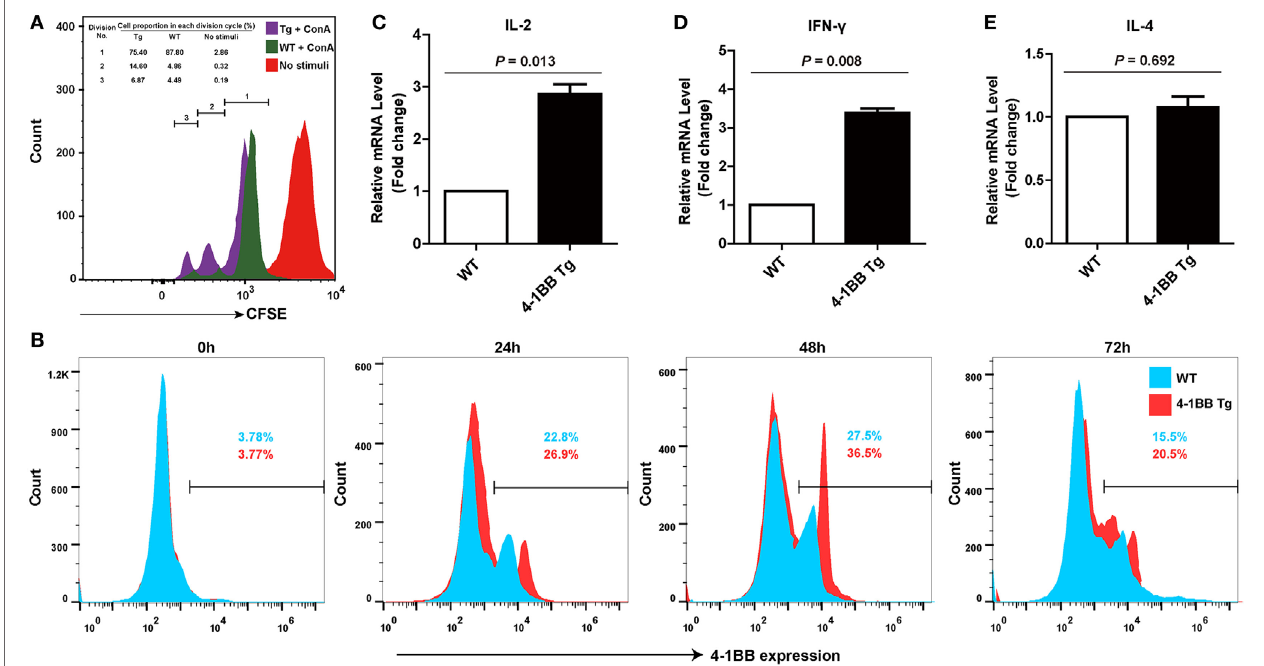
FigUre 4 | 4-1BB overexpression promotes the proliferation of peripheral blood lymphocytes and the levels of Th1 cytokines mRNA expression. (a) Equal numbers of peripheral blood lymphocytes were labeled with carboxyfluorescein diacetate succinimidyl ester and stimulated with concanavalin A. Representative results of an in vitro proliferation assay showed that 4-1BB transgenic pigs had a greater proliferation capacity compared with pigs of wild-type control. The percentages of cells in each division cycle compared with non-stimulated control (complete RPMI media) were indicated. (B) Kinetics of 4-1BB expression on in vitro activated T cells. Peripheral blood lymphocytes were stained for 4-1BB expression after stimulation with ConA at indicated times. (c–e) : IL-2 (c) , IFN- γ (D) , but not IL-4 (e) mRNA expression in peripheral blood lymphocytes were determined by quantitative real-time PCR during the primary response to porcine reproductive and respiratory syndrome virus vaccination. 4-1BB Tg, 4-1BB transgenic pigs; WT, wild-type pigs as a control. The results shown are representative of three independent experiments. Data are presented as mean values ± SEM. P < 0.05 was considered statistically significant.